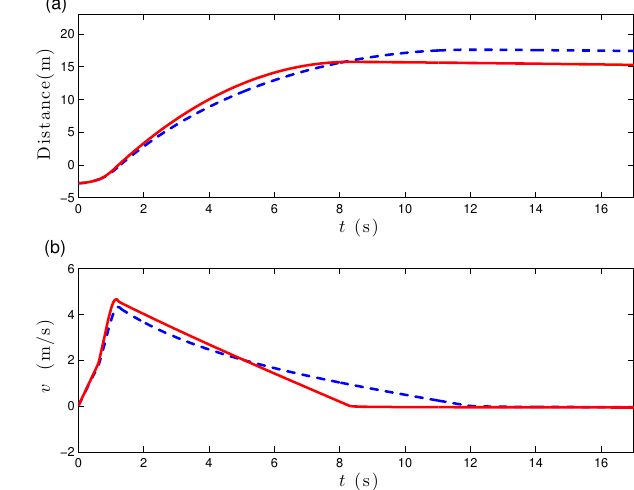
Figure 8. Displacement and velocity for two values of the car mass m = 0 . 02Kg (dashed), m = 0 . 2Kg (solid) and with parameters given in Table 2 and µ k = 0 . 2. The heavier (solid) car stops before the lighter car when the track is su ffi ciently